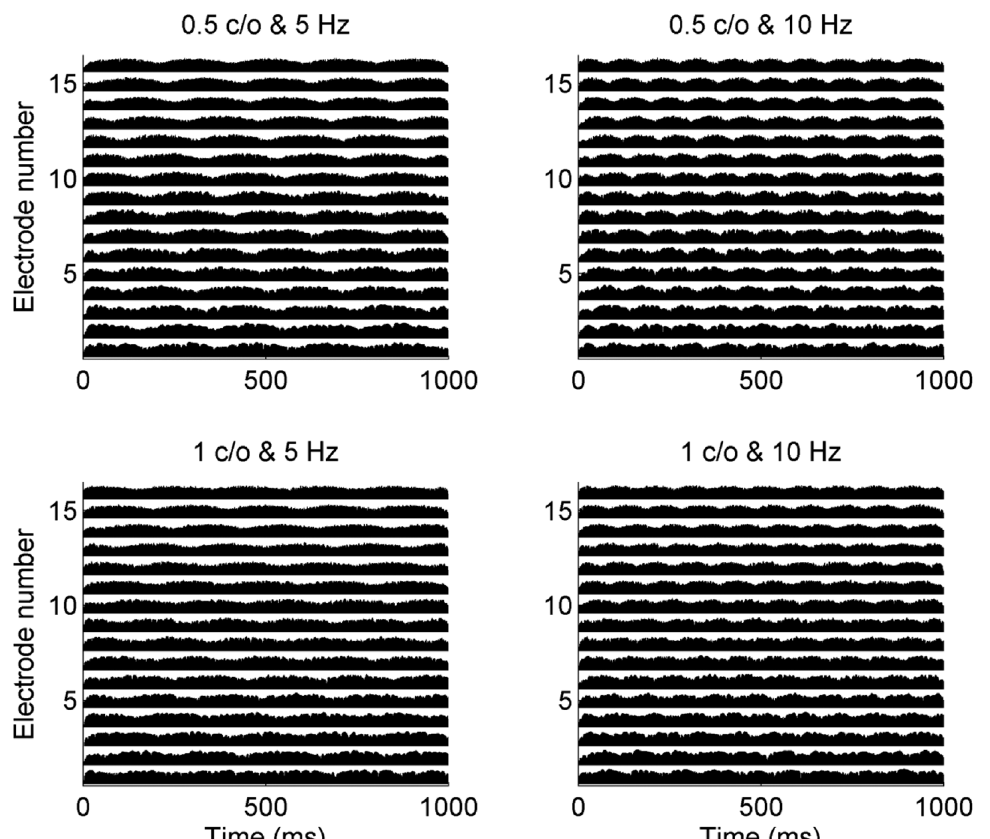
Fig 2. The electrode outputs in response to the four STM stimuli shown in Fig 1. For these simulations, HiResolution 1 strategy (Advanced Bionics Corporation) was